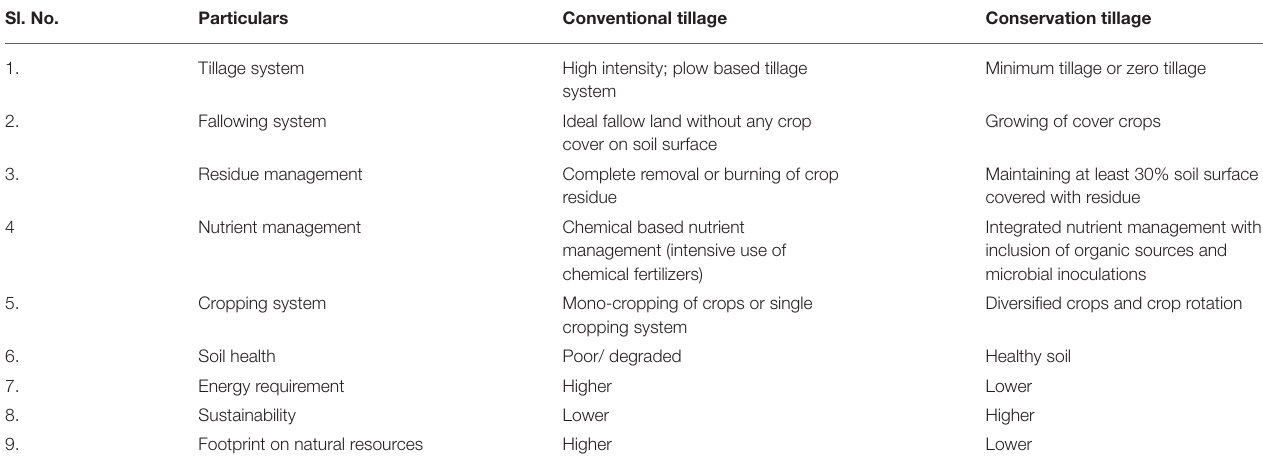
TABLE 7 | Differences between conventional tillage and conservation tillage. Sl.